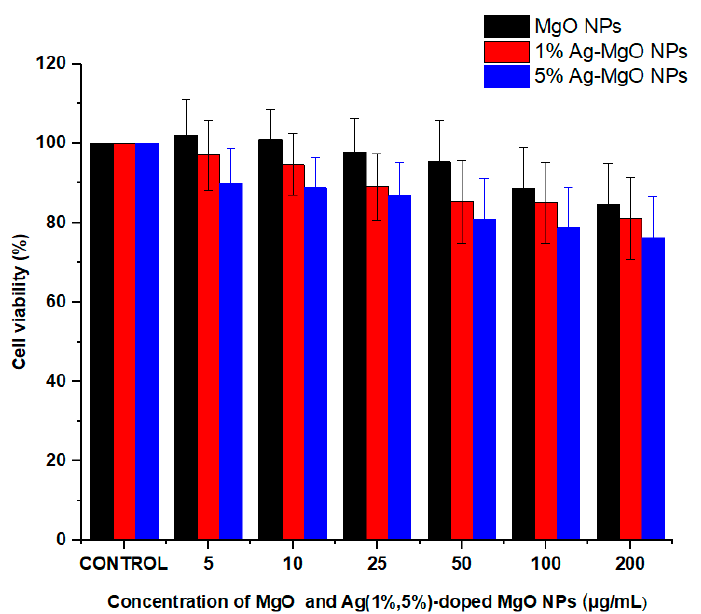
Figure 12. Cytotoxicity of pure and Ag (1%, 5%) ‐ doped MgO NPs in HUVECs by MTT assay.